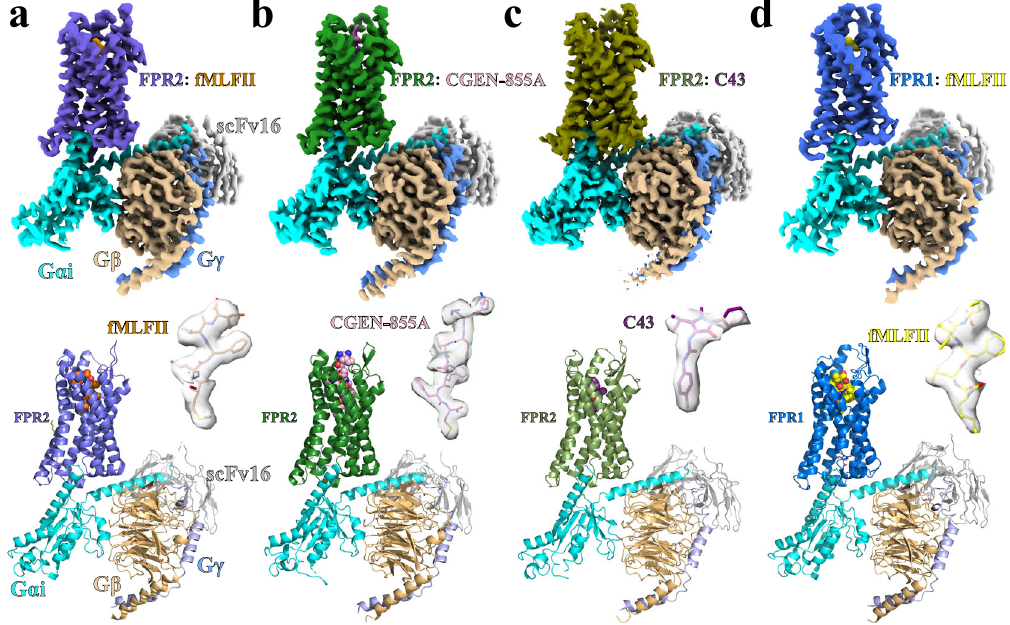
Fig. 1 Overall structures of the G i -coupled FPR1 and FPR2 complexes. a – d Upper panels show cryo-EM density maps of the FPR2-G i complexes with fMLFII ( a ), CGEN-855A ( b ), C43 ( c ), and the FPR1-G i complex with fMLFII ( d ). Lower panels show structural models of the four complexes and ligand density maps.